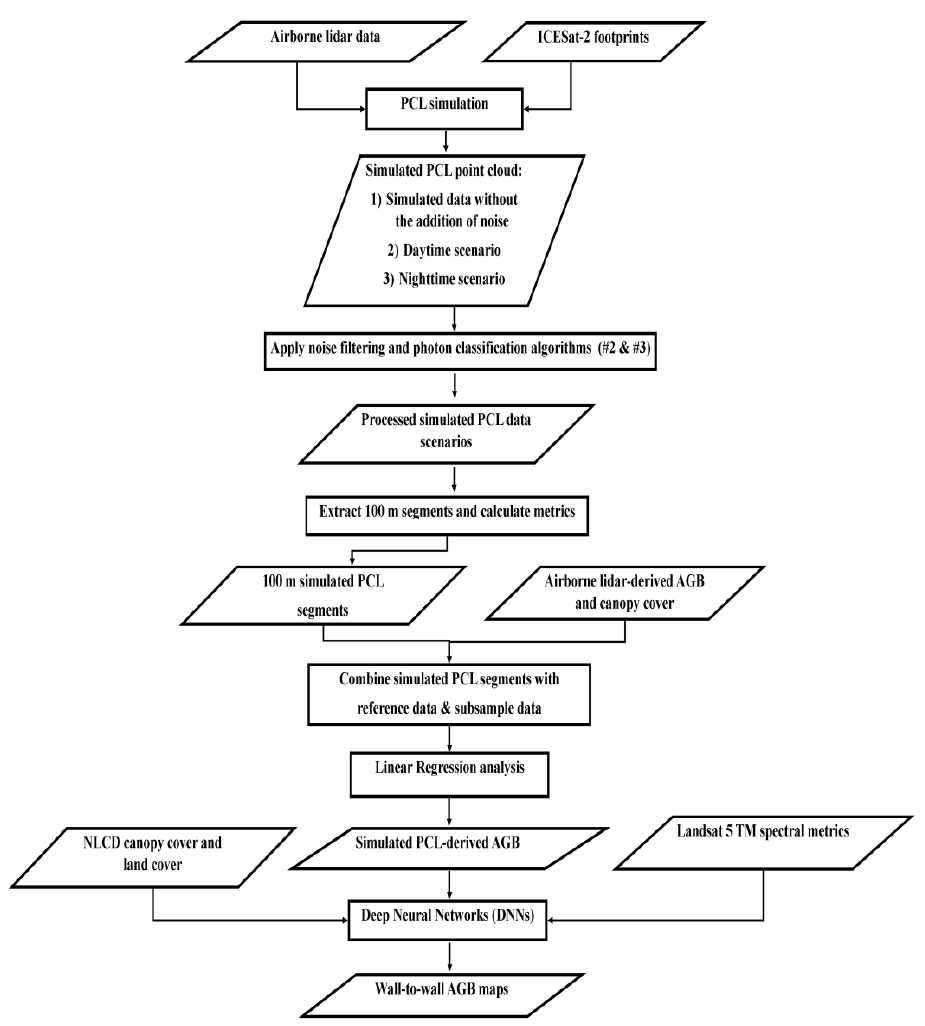
Figure 3. Workflow for mapping AGB using simulated ICESat-2 and Landsat data.